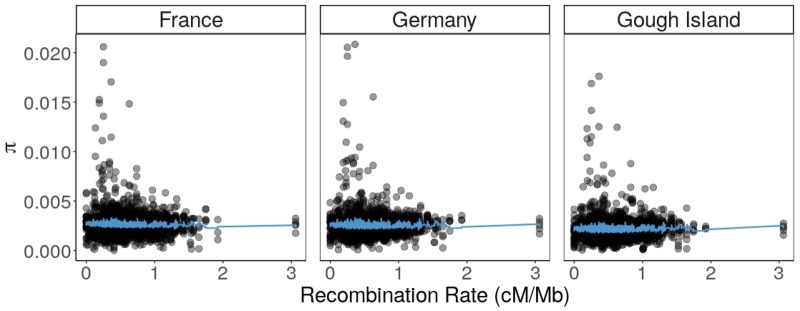
—Nucleotide diversity (θπ) computed over 1-Mb intervals plotted against recombination rate (cM/Mb) across the autosomal genome. Fitted values (blue line) were obtained from the multiple linear regression of θπ against recombination rate and other genomic covariates. The effect size of recombination rate is not statistically significant for France (P = 0.918) or Germany (P = 0.397), but is significant for Gough Island (P = 0.038).